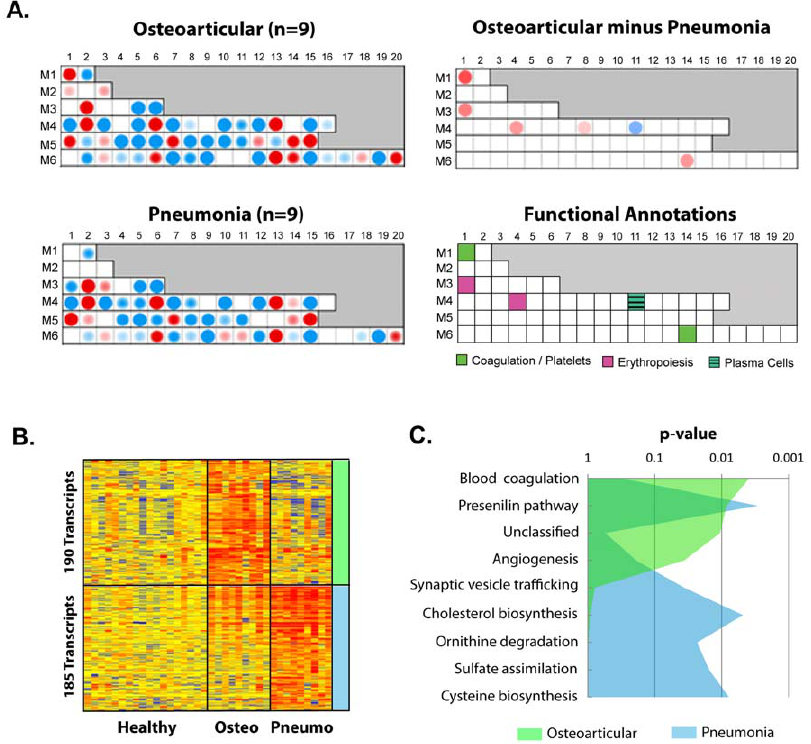
Figure 5. The osteoarticular infection signature displays increased blood coagulation. We compared the transcriptional signatures from patients with pneumonia and patients with osteoarticular infections. To properly balance osteoarticular and pneumonia groups, patients with pneumonia with a draw index less than 0.75 (nine patients) were selected (active disease). Nine patients with osteoarticular infection were selected with matching MDTH so that global quantitative signature was equivalent between the two groups. Nine healthy controls were selected from the training and nine from the test set (18 healthy controls in total) as reference. A. Top left panel: mean module map for the nine patients with osteoarticular infections compared to the 18 healthy controls. Bottom left panel: mean module map for the 9 patients with staphylococcal pneumonia compared to the 18 healthy controls. Top right panel: substraction map of osteoarticular infections minus pneumonia. Only differences greater than 40% are represented. Bottom right panel : Annotation legend for modules identified. B. Heatmap representing genes differentially expressed (t-test, , 0.05, no correction) between osteoarticular infections and pneumonia (hierarchical clustering, Pearson). 190 genes were upregulated 1.5-fold or more in osteoarticular infections versus pneumonia and healthy controls. 185 genes were upregulated 1.5-fold or more in pneumonia versus osteoarticular infections and healthy controls. C. Area chart representing PANTHER comparison for pathway enrichment between the two lists from